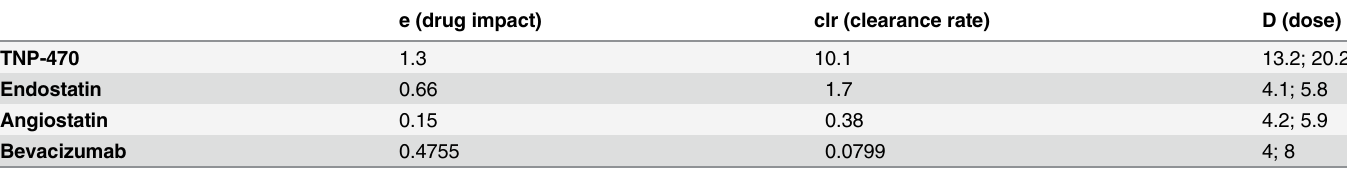
Table 2. Dosage of different agents giving similar therapeutic effects.